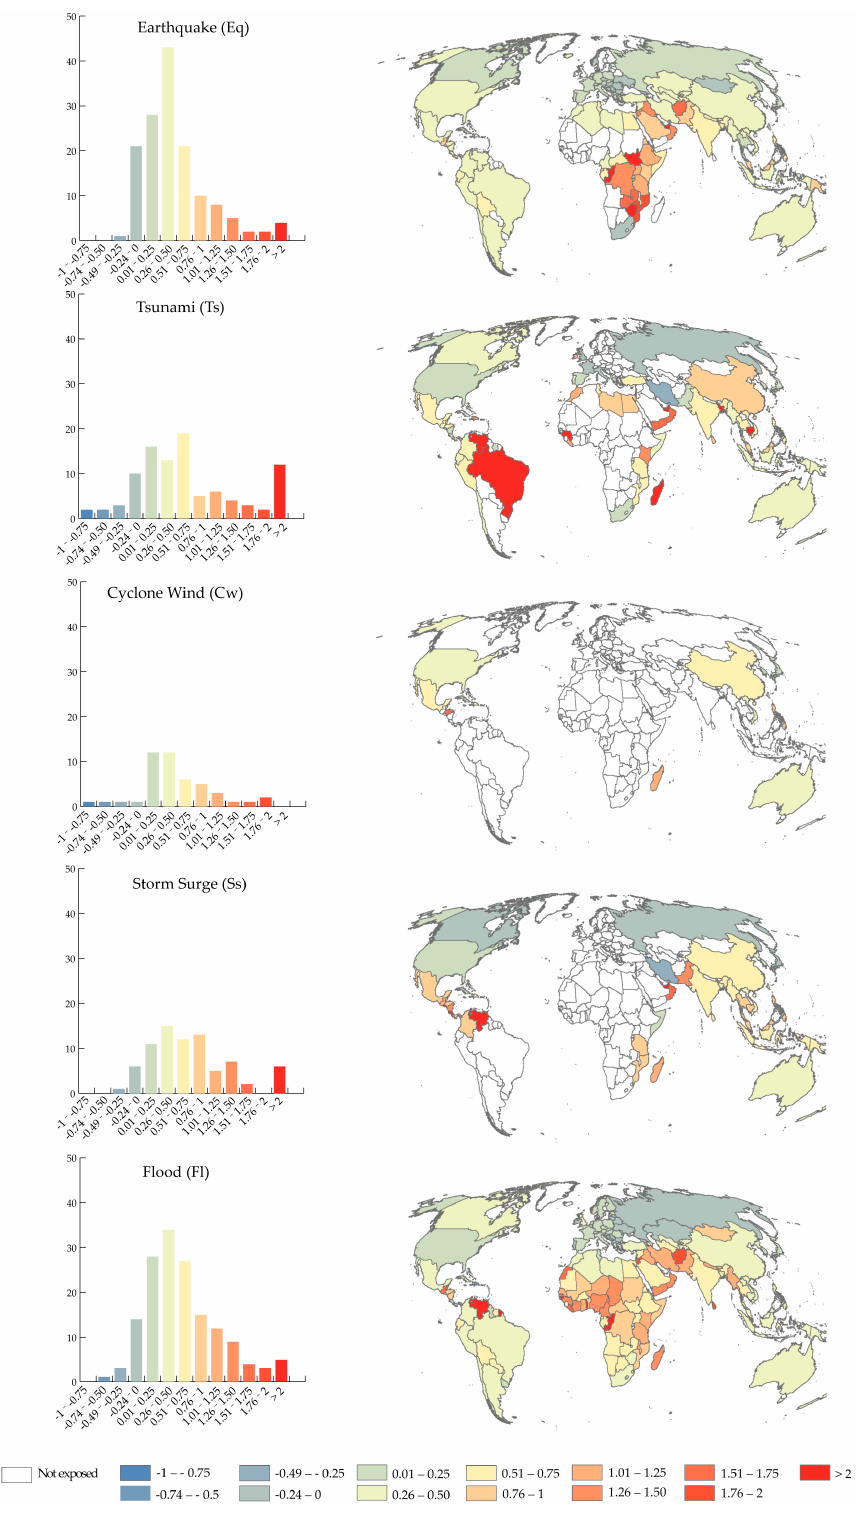
Figure 9. Frequency distributions (bar charts) and corresponding geographic representation of countries-excluding small islands-with population exposure changes. Changes refer to the period 1990–2015, and the classes of change with 25% intervals range between − 100% and 200%.